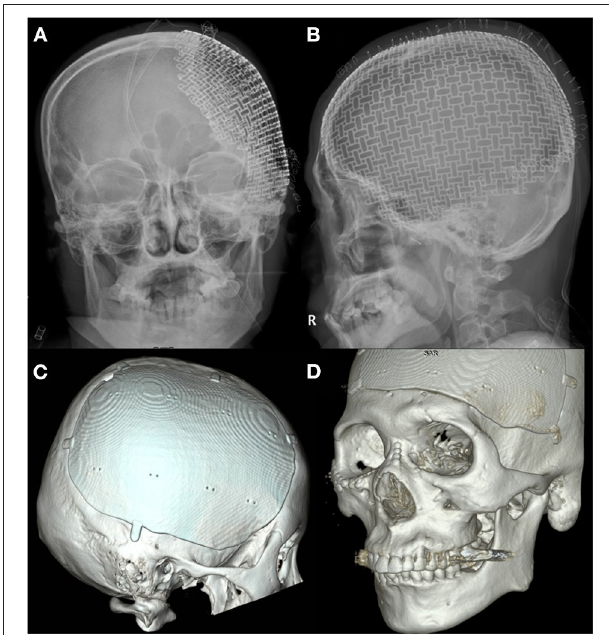
FIGURE 3 | Advances in three-dimensional (3D) printed patient-specific titanium implant. (A) X-ray anteroposterior skull view of three-dimensional (3D) printed implant used in the beginning. (B) X-ray lateral skull view of 3D printed implant used in the beginning. (C) 3D reconstructed view of advanced 3D printed implant for the right frontotemporoparietal skull defect. (D) 3D reconstructed view of advanced 3D printed implant for the frontotemporal skull defect crossing the